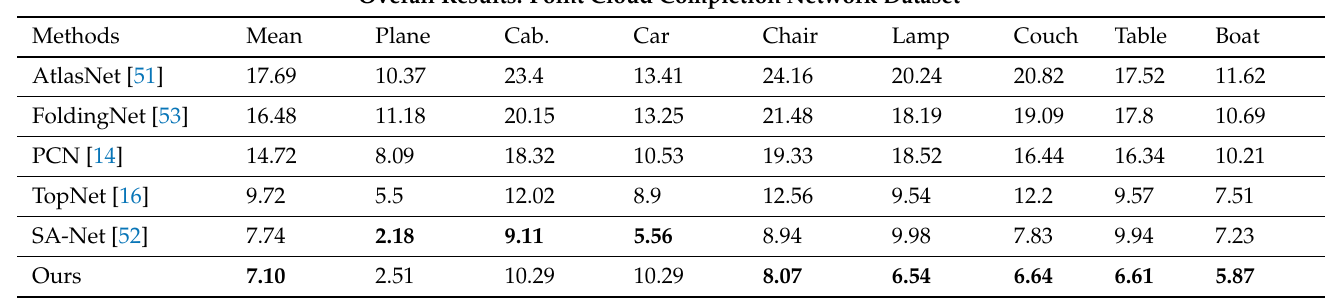
Table 2. Point cloud completion comparison on Point Cloud Completion dataset in terms of per point Chamfer distance 10 4 (lower is ×